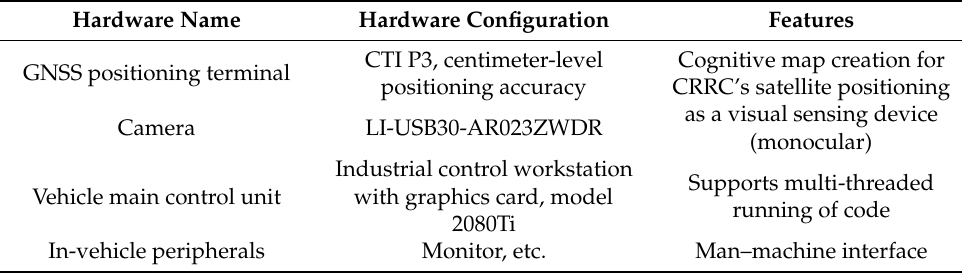
Table 1. Experimental platform hardware.